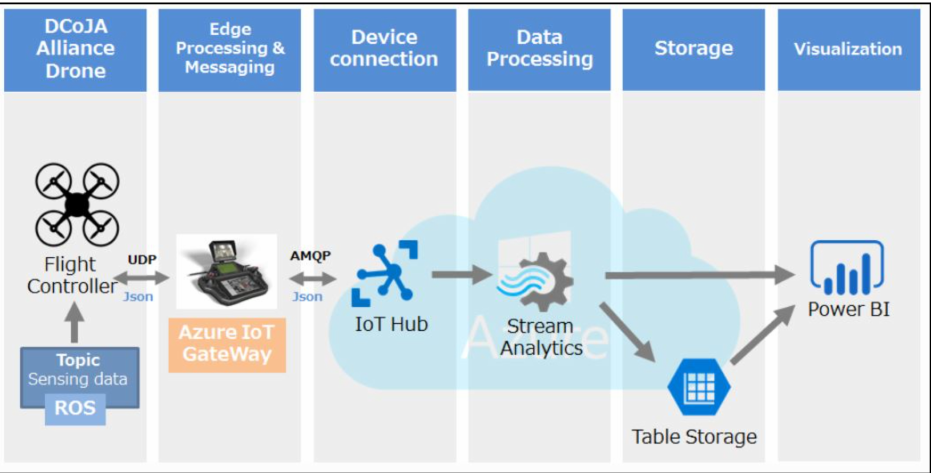
Figure 1. UAV architectural